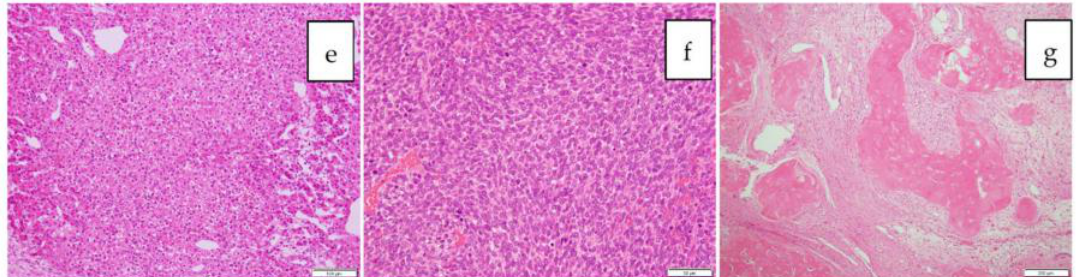
Figure 3. a – g : Mixed epithelial and mesenchymal type with teratoid features, post-chemotherapy. The formalin-fixed cross section of the liver is shown ( a ), and the tumor is encircled with a yellow-dotted line. The tumor is heterogeneous macroscopically, and fluorescence can be observed only in the small area marked with a white-dotted line ( b : white-light mode, c : NIR mode, d : mapping mode). A histological analysis showed that while the fluorescent area corresponded to well-di ff erentiated HB ( e ), the non-fluorescent area consisted of poorly di ff erentiated HB ( f ) and an osteoid lesion ( g ). Scale bar: 100 µ m.